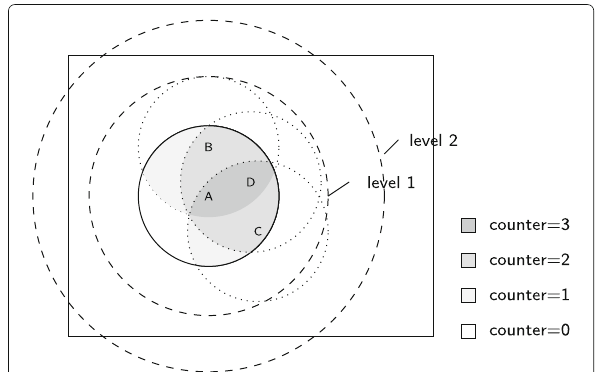
Fig. 13 Geometric interpretation of counter-based flooding that will be covered by c number of circles divided by all possible points in the region. This implies that the prob- ability should be expressed in terms of areas as in Eq. 34 where A c denotes the intersection area of c circles and A reg is the total area of the region in which the circles are deployed. The centers of the circles are the potential rebroadcasters.